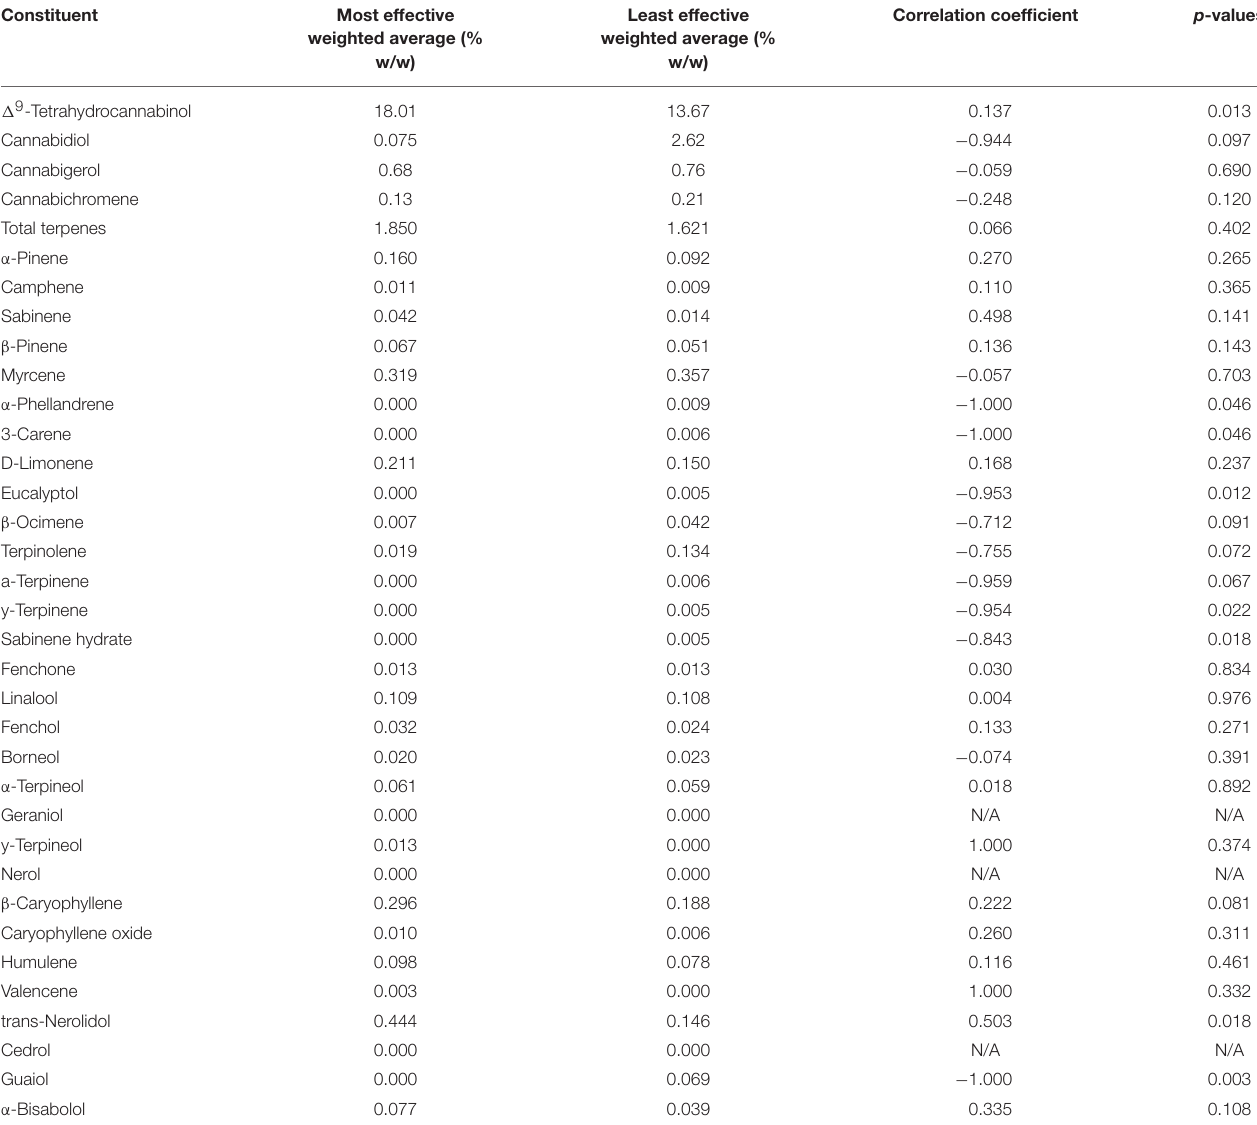
TABLE 4 | Weighted averages of all terpenes and cannabinoids for the top four most effective and least effective strains, their correlation coefficient, and p -values. Constituent Correlation coefficient p